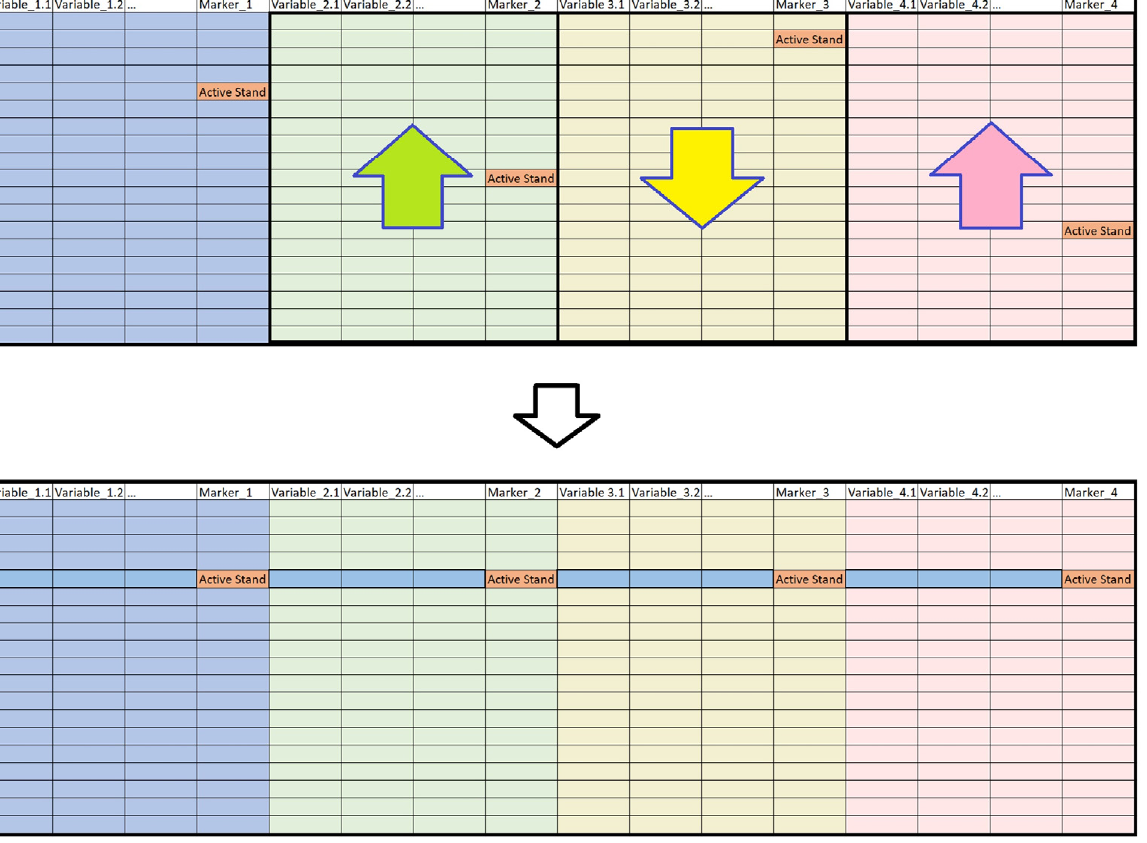
Figure 4. Communication diagram between different devices in the NCVI/NMFI setup. A timer was used for syncing signals between NOVA, NIRS, and EMG, by manually pushing a key on the key- board of each computer upon a 5 s countdown approaching each event during the assessment. (1) Instrument-level data syncing As a first step, the NOVA data frame was synced. This was completed by shifting the columns that originated from each data file, so that all event markers appearing in the merged data frame were aligned, as illustrated in Figure 3 where, for illustration pur- poses, the event “Active Stand” is used for aligning the data frames. However, in practice, syncing could be done by any other event or moment in the assessment protocol. It is by the same method that the merged EMG data frames were synced. (2)